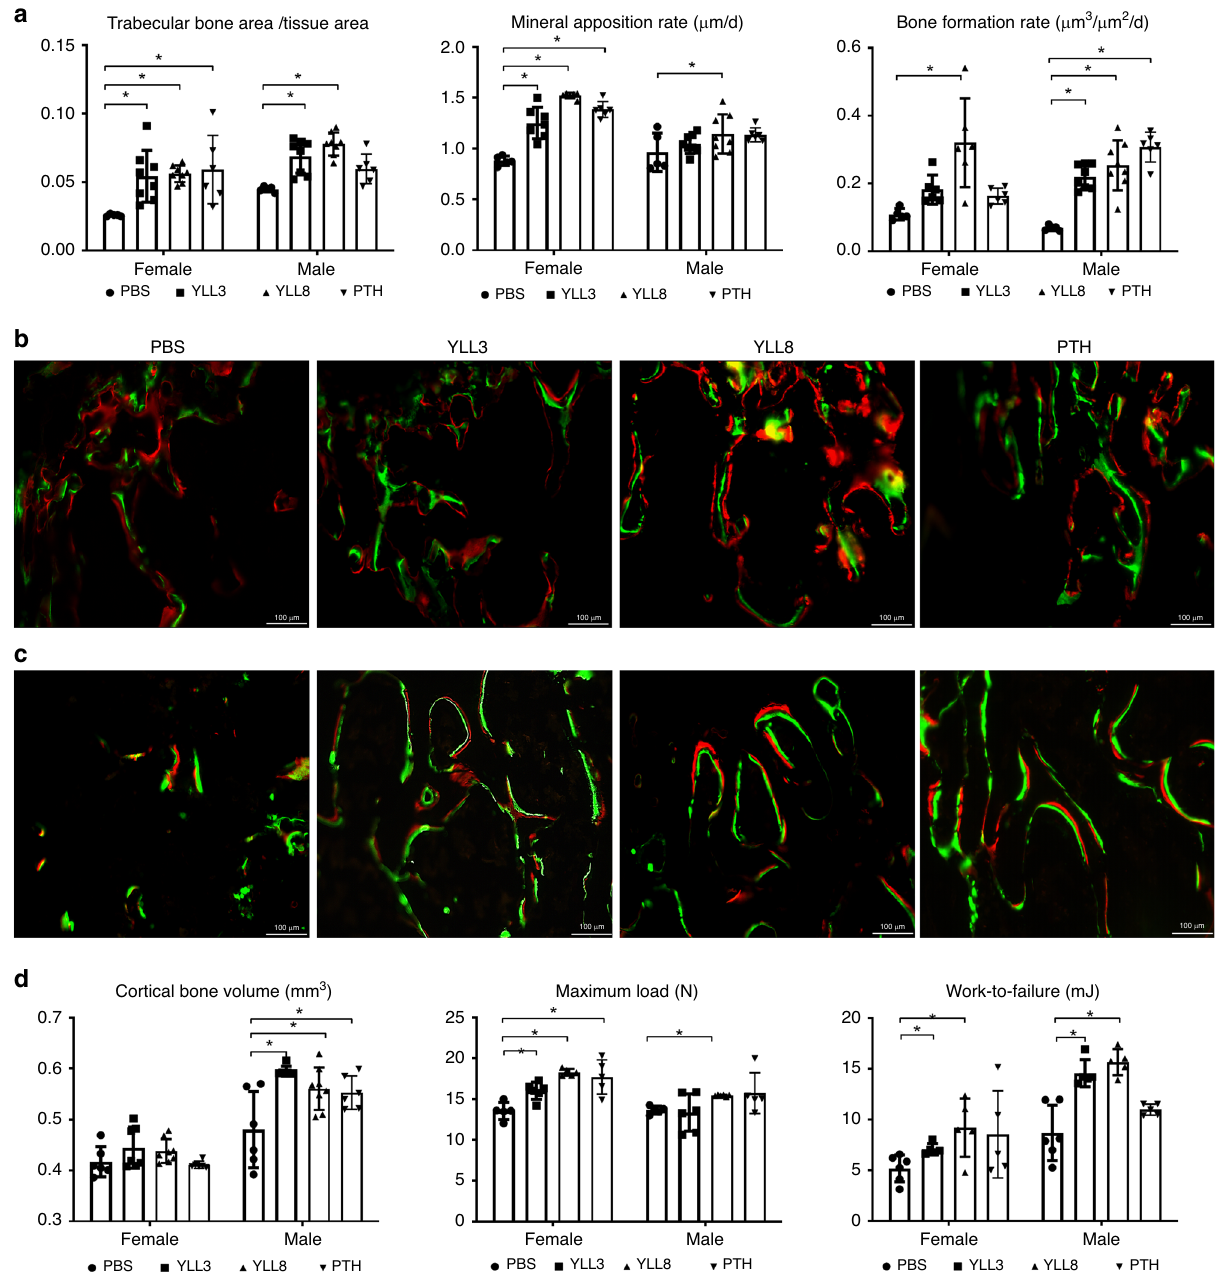
Fig. 4 YLLs augmented bone formation in vivo in normal adult mice. Four-month-old female and male mice were treated with PBS control, YLL3 or YLL8 at 10 μ g/kg or hPTH(1 – 34) at 25 μ g/kg, s.c., 5x/week for 21 days. All mice received Calcein (green) and Alizarin red (red) at − 8 and − 1 days before euthanization. a Trabecular bone volume and surface-based bone formation were measured in the distal femur metaphysis (DFM). Columns represented individual values in each group and the error bars represented standard deviations. N = 7 animals in PBS and PTH-treated groups, and n = 8 mice in YLL3 and YLL8-treated groups. * p < 0.001 between the treated groups versus PBS-treated group using one-way ANOVA followed by Dunnett ’ s multiple comparison post hoc test for the trabecular bone area/tissue area and bone formation rate; and p < 0.05 between the YLL8-treated group versus PBS- treated group for the male Mineral apposition rate using one-way ANOVA followed by Dunnett ’ s multiple comparison post hoc test in the males. b Representative images were taken from the DFM trabecular region in the female mice. Scale bar = 100 µ m. c Representative images were taken from the DFM trabecular region in the male mice. Scale bar = 100 µ m. d Cortical bone mass was measured at the mid-femurs by microCT; bone strength was obtained by three-point bending of the femurs. Columns represented individual values in each group and the error bars represented standard deviations. N = 6 animals/groups. * p < 0.001 between the treated groups versus PBS-treated group for the cortical bone volume in the males, maximum load in the females and work-to-failure in the males using one-way ANOVA followed by Dunnett ’ s multiple comparison post hoc test; and p < 0.05 between the YLL8- treated group versus PBS-treated group for the maximum load in the males and work-to-failure in the females using one-way ANOVA followed by Dunnett ’ s multiple comparison post hoc